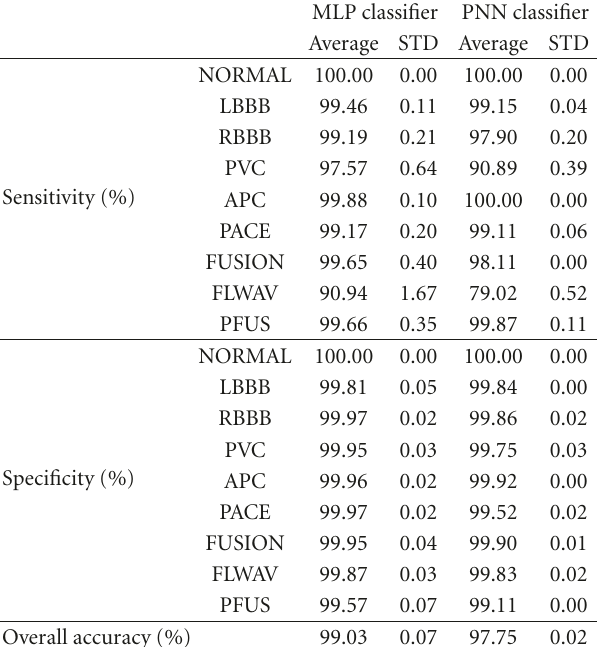
Table 3: Classification results of the proposed scheme with MLP